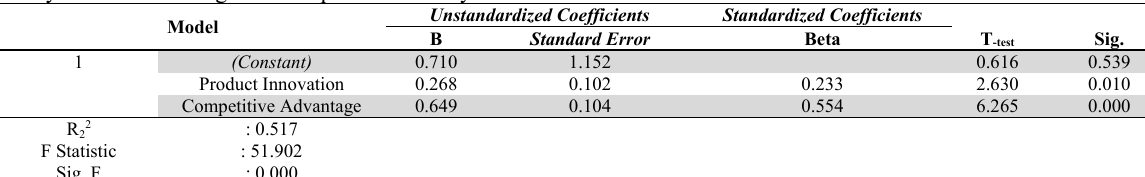
Analysis Results of Regression Equation Pathway 2